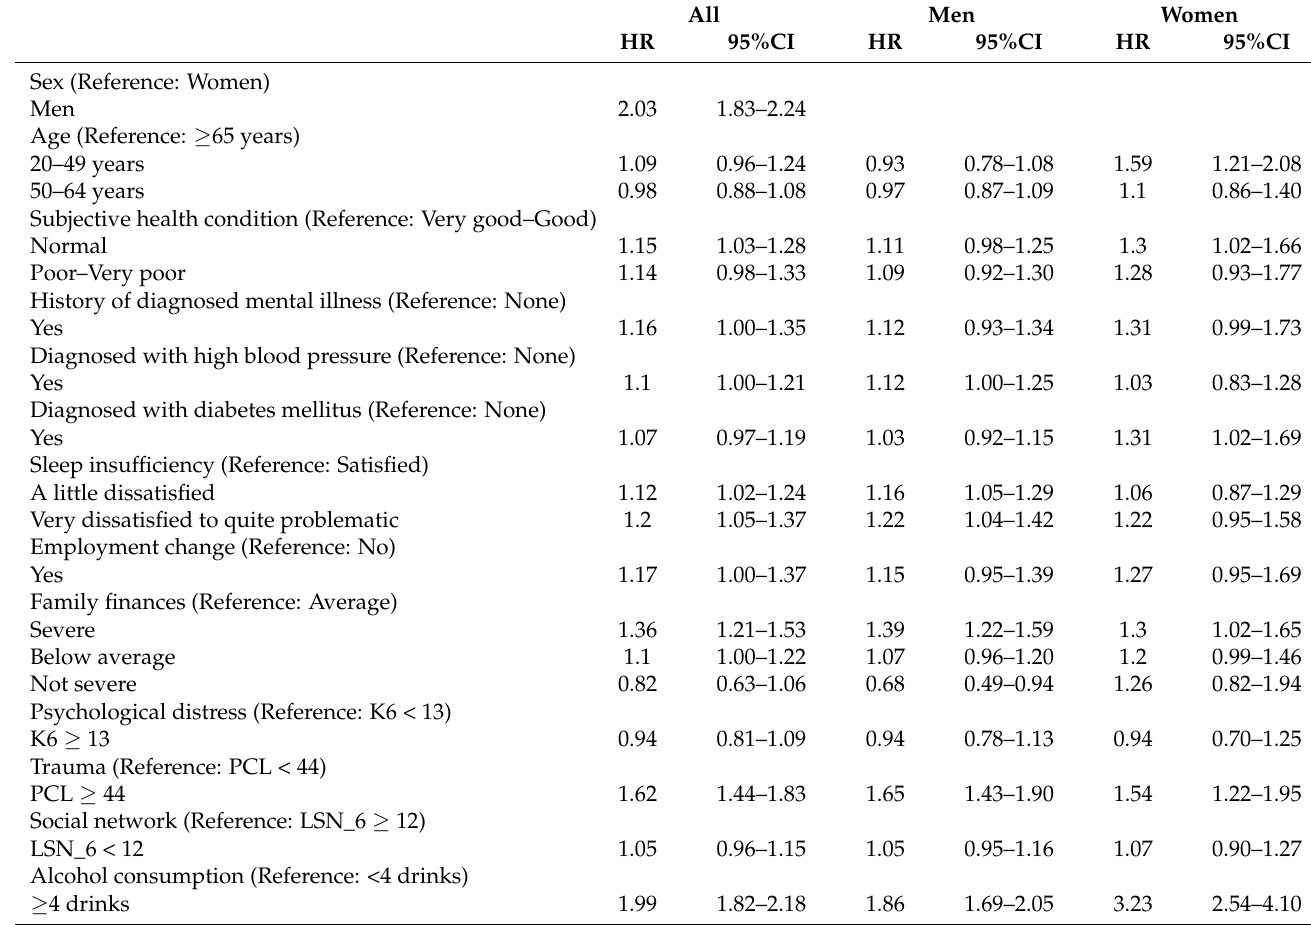
Table 3. Multivariate-adjusted HRs and 95% CIs for the occurrence of problem drinking from FY 2012 to FY 2017.